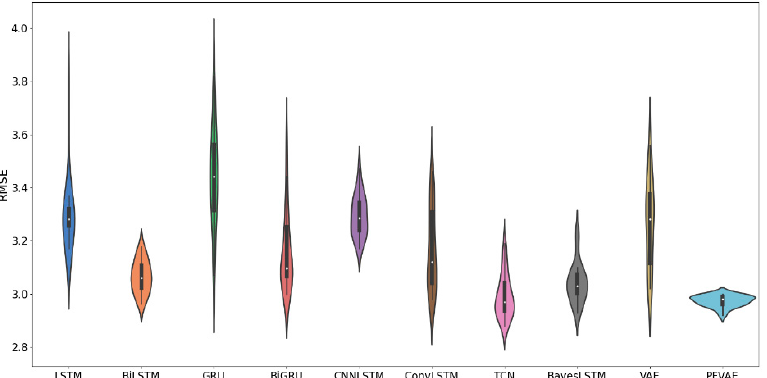
Figure 8. RMSE violin plots for each model run 20 times on the temperature dataset.